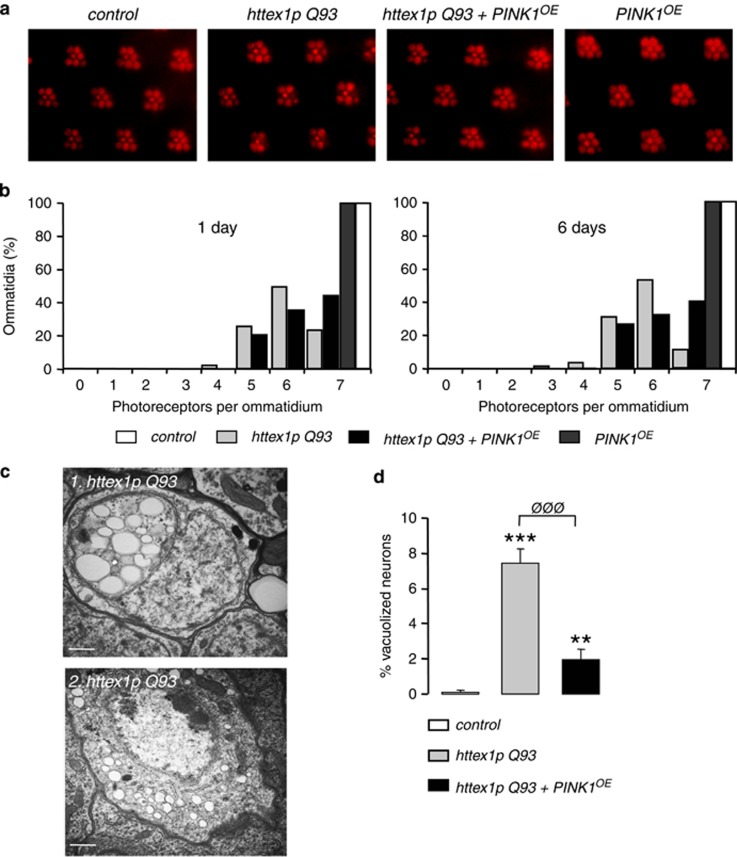
Drosophila PINK1 overexpression rescues neurodegeneration in flies expressing httex1p Q93 in neurons. (a) Pseudopupil images from 1-day-old flies expressing no transgene (control), httex1p Q93 alone, httex1p Q93 together with Drosophila PINK1 (PINK1OE) or PINK1OE alone under the pan-neuronal driver elav-GAL4. In control flies, seven photoreceptors are visible, whereas the expression of httex1p Q93 induces photoreceptor neuron loss. PINK1OE counteracts the httex1p Q93-induced photoreceptor degeneration. (b) Number of photoreceptors per ommatidium in flies expressing no transgene (control), httex1p Q93, httex1p Q93+PINK1OE or PINK1OE alone at day 1 or 6 after eclosion. Significant rescue of neurodegeneration was observed at both ages when PINK1 was overexpressed in HD flies (n≥10 flies; P<0.0001, Mann–Whitney U-test). (c) Transmission electron microscopy images showing highly vacuolized neurons in 12-day-old flies expressing httex1p Q93 in neurons. Scale bar: 50 nm. (d) Percentage of vacuolized degenerative neurons in 12-day-old flies expressing no transgene (control), httex1p Q93 alone or together with PINK1OE. PINK1OE significantly reduces mHtt-induced neurodegeneration (Student's t-test, **P<0.01, ***P<0.001 versus control; ØØØP<0.001 versus
httex1p Q93). Quantifications were performed as followed: n>150 neurons in six flies per condition